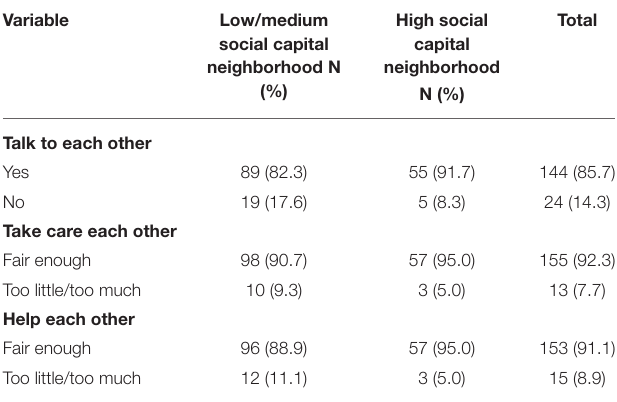
TABLE 1 | Patterns of social interaction and support at baseline across different